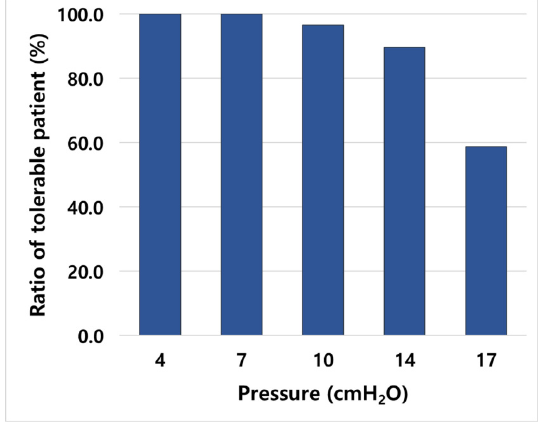
Figure 2. Cumulative proportion of tolerable patients at each pressure.